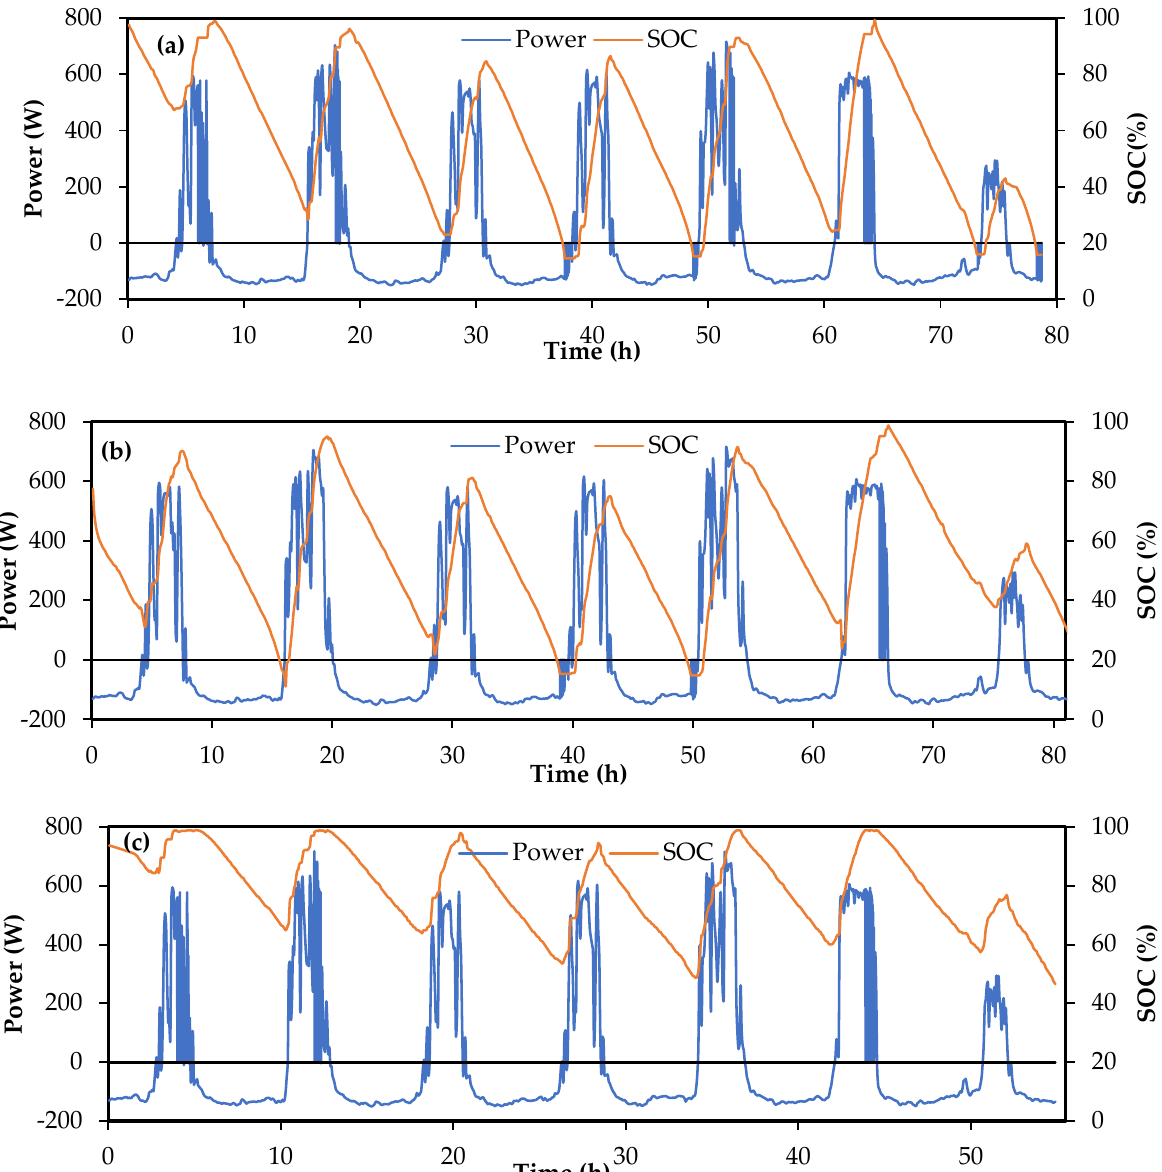
Figure 4. Battery performance with SoC variation for S P = ½ and S T = ½ for ( a ) 35 L electrolyte ( b ) 40 L electrolyte and ( c ) with 40 L electrolyte with SOC variation for S P = ½ and S T = 1 / 3 .